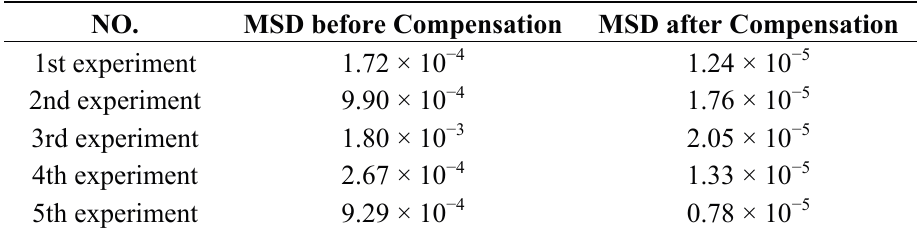
Figure 10. The primary outputs of IFOG and the compensated outputs of IFOG. Table 2. MSD before and after